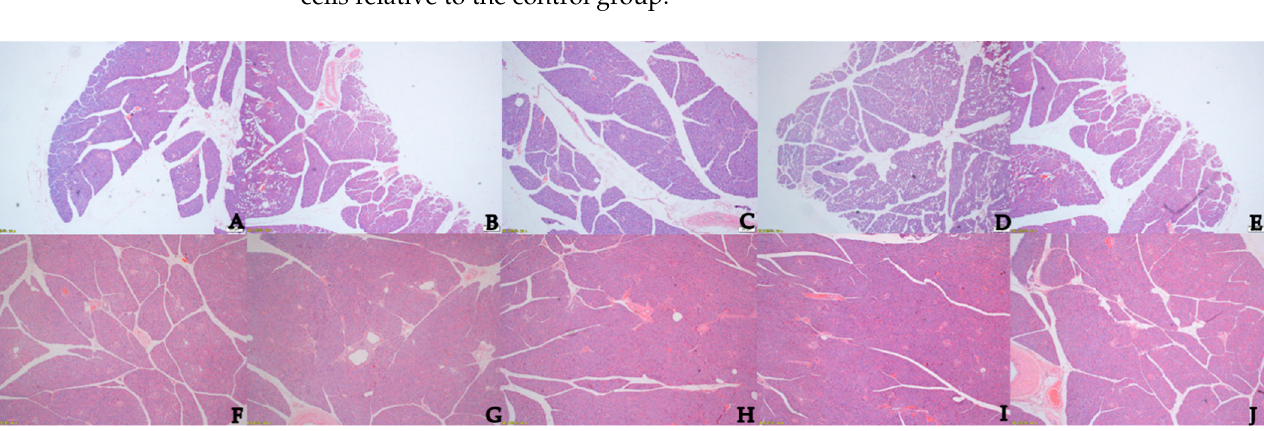
Figure 1. ( A ) Internal morphological structure of pancreatic tissue under 10× microscope; ( B ) Inter- nal morphological structure of pancreatic tissue under 20× microscope.